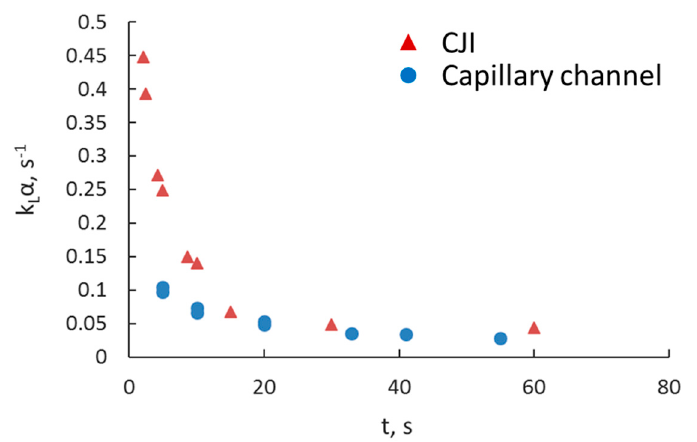
Figure 14. Overall volumetric mass transfer coefficient as a function of residence time for the 3.2 mm T-junction capillary channel and the 3.2 mm CIJ cell.